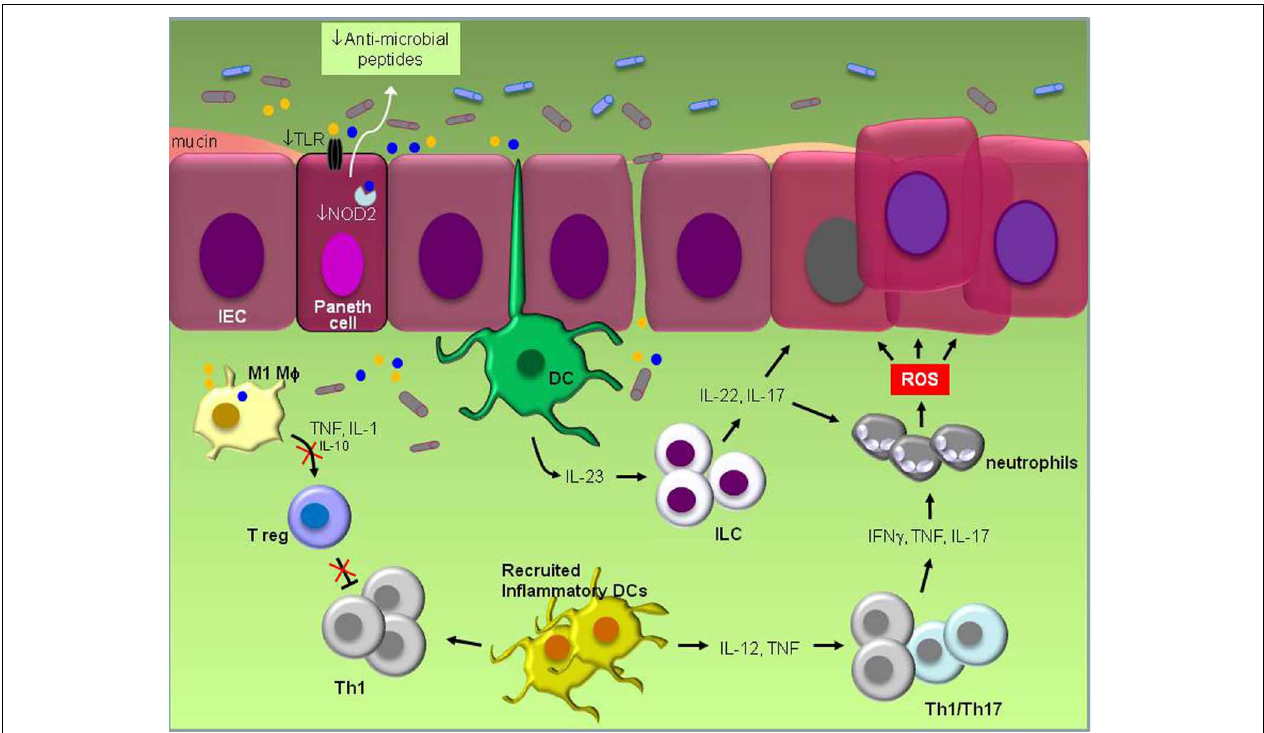
FIGURE 1 | Schematic representation of known pathogenic events in experimental IBD. Defective TLR and NOD signaling in Paneth epithelial cells leads to reduced “sensing” of bacterial products (yellow and blue circles) and reduced production of anti-microbial peptides. The ensuing disruption of microbiota balance which may also be influenced by the frequent use of antibiotics and/or diet stimulates inflammation that is largely orchestrated by resident dendritic cells (DCs). Their activation by products of pathogenic bacteria induces IL-23 which in turn engages innate lymphoid cells (ILC) to produce IL-22 and IL-17. Inflammation also results in the recruitment of inflammatory DCs which secrete IL-12 and TNF and increase IFN γ , TNF and